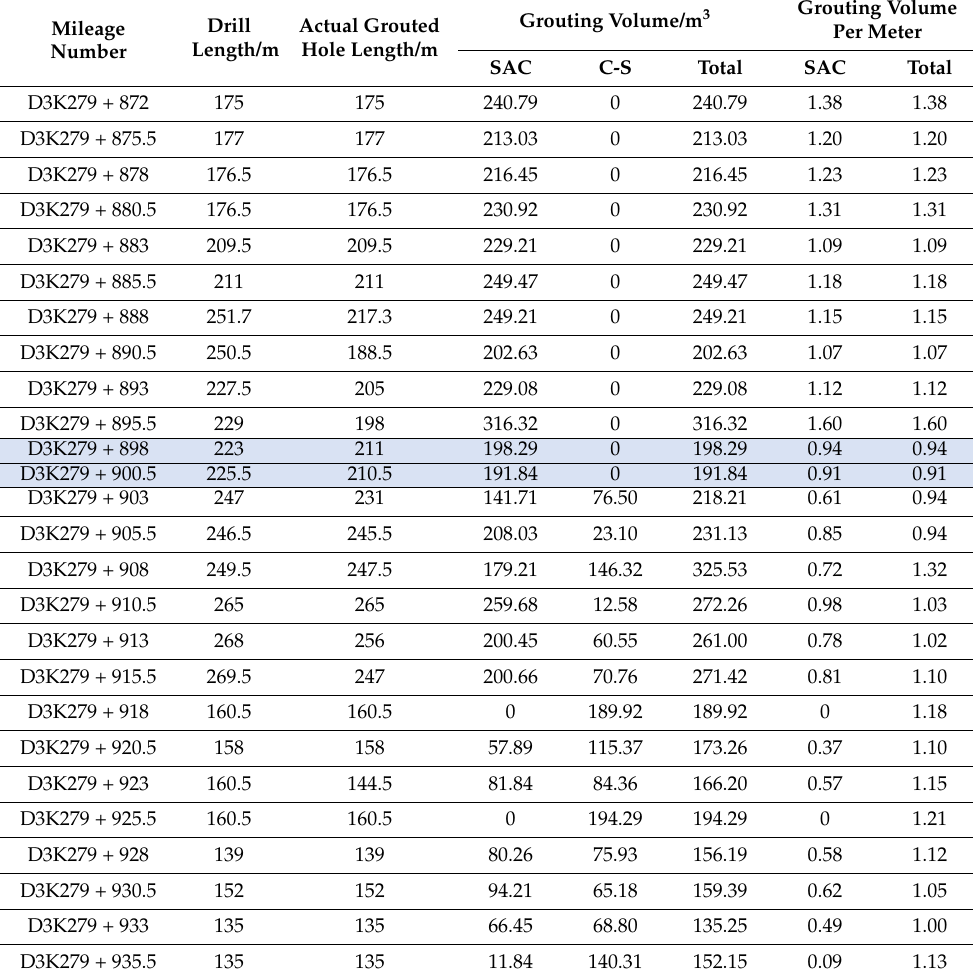
Table 4. Implementation of grouting in Yujingshan tunnel right lane.